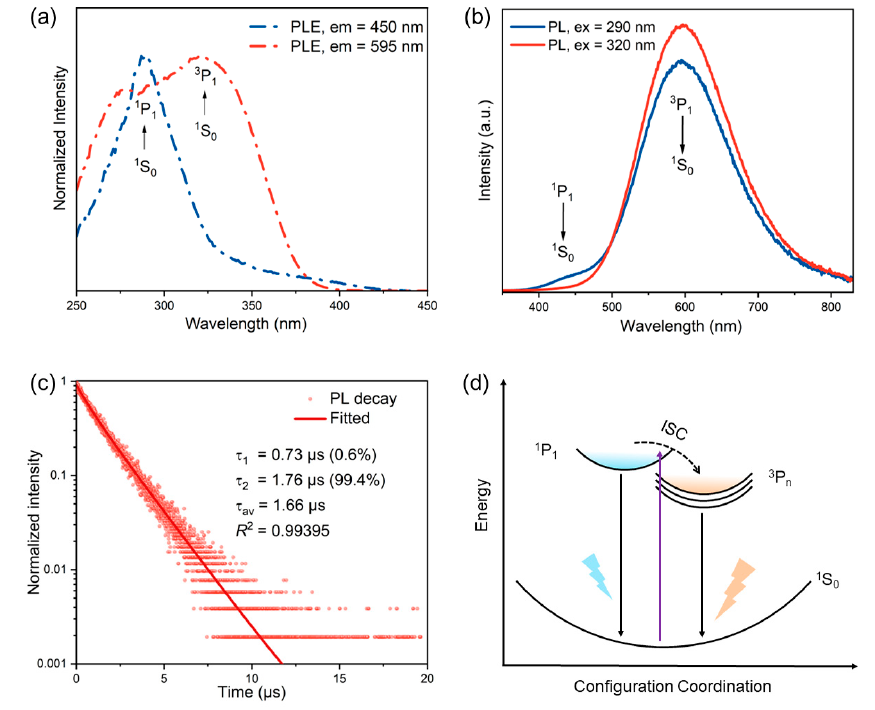
Figure 2. Steady-state and time-resolved PL spectra of [H 2 BPZ][SbCl 5 ] · H 2 O at RT. ( a ) The steady-state PLE spectra of [H 2 BPZ][SbCl 5 ] · H 2 O, measured with emission wavelengths at 450 and 595 nm, respectively. ( b ) The steady-state PL spectra of [H 2 BPZ][SbCl 5 ] · H 2 O with excitation wavelengths at 290 and 320 nm, respectively. ( c ) Time-resolved PL spectrum of [H 2 BPZ][SbCl 5 ] · H 2 O at 595 nm emission. The PL lifetime is fitted, calculated, and labelled. ( d ) The proposed PL mechanism in the configuration coordinate